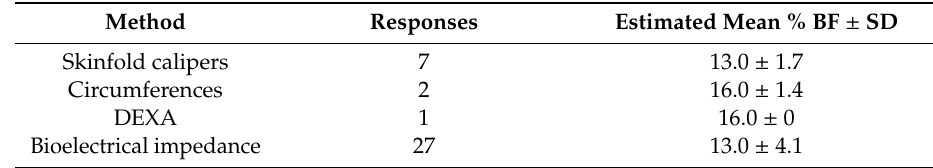
Table 2. Reported methods for measuring body fat and respective estimated body fat percentage for both special operations units, Brasilia (Brazil), 2019 ( n = 37).